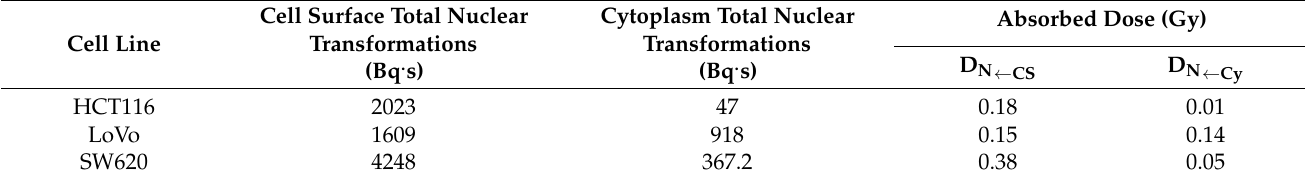
Figure 4. The colorectal cancer cell lines ( A ) HCT116; ( B ) LoVo; ( C ) SW620 treated with the indicated concentrations of I-C19 for 72 h ( p < 0.05); ( D ) treatment with 131 I-C19 at a concentration of 1.8, 6.8 and 8.8 µ M in LoVo, SW620 and HCT116, respectively, significantly reduced the viability of the three colorectal cancer cell lines in comparison with unlabeled I-C19; ( E ) 131 I-C19 uptake experiments. After incubation for 1, 3 and 5 h, 131 I-C19 uptake by cancer cells significantly increased. n = 3; **** p < 0.0001. Table 2. Radiation absorbed doses produced by the uptake and internalized activity of 131I-C19 to the HCT116, LoVo and SW620 cancer cell